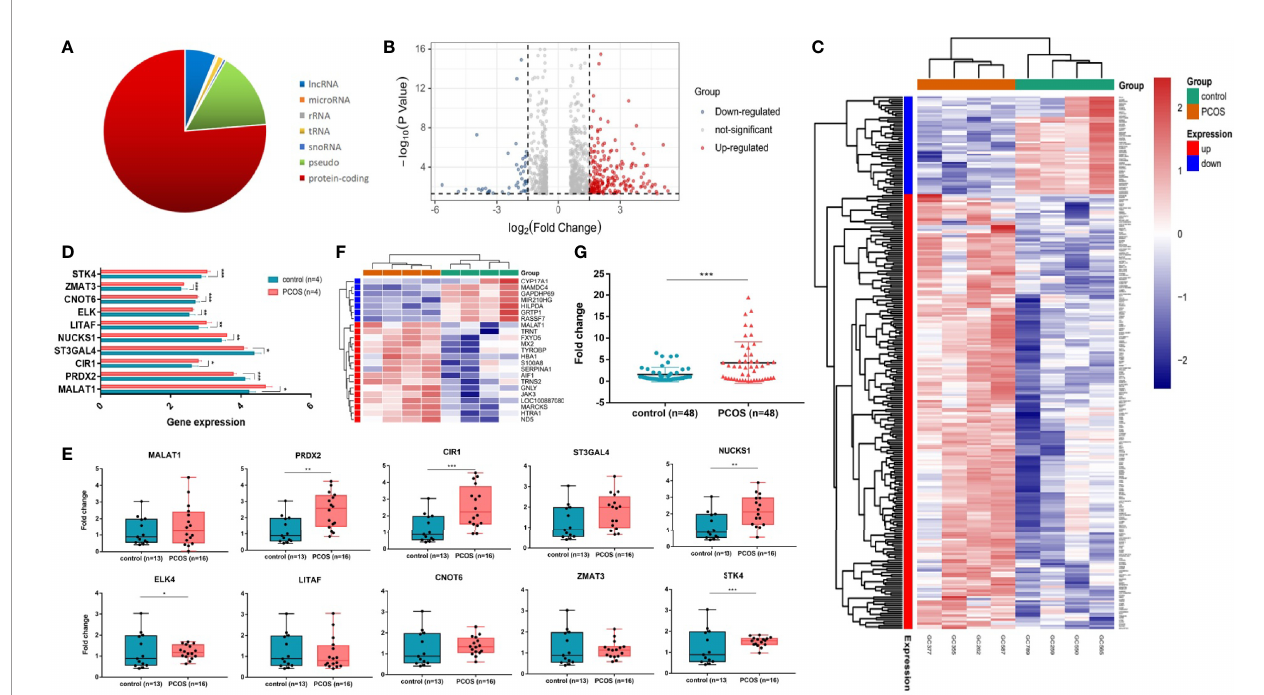
FIGURE 1 | LncRNA MALAT1 is upregulated in granulosa cells of women with PCOS. (A) Graph showing the biotypes of RNA transcriptome sequencing pro fi le. (B , C) Graph showing the whole differentially expressed genes. Among them, 48 were downregulated and 216 were upregulated. Red: upregulated genes; blue: downregulated genes. (D) Ten differentially expressed genes (DEGs) in RNA-seq. (E) Graph showing the DEG expression level in granulosa cells of women with or without PCOS (13 control patients and 16 PCOS patients) (* p < 0.05, ** p < 0.05, *** p < 0.001). (F) Heatmap showing the hierarchical clustering of the most striking differentially expressed genes in patients with and without PCOS. Red: upregulated genes; green: downregulated genes. (G) Graph showing the expression levels of MALAT1 in a larger cohort (48 control patients and 48 PCOS patients) using RT-qPCR (*** p <